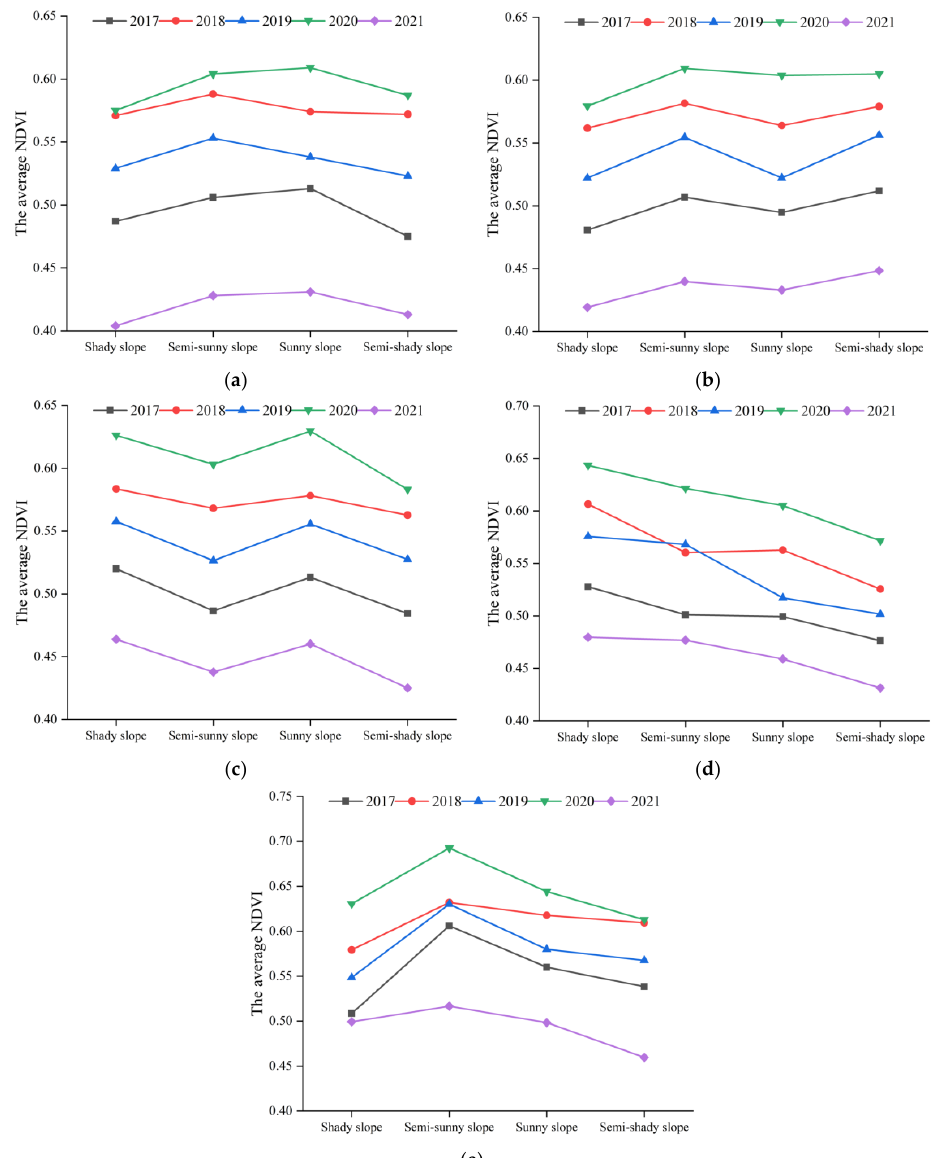
Figure 20. NDVI of different slopes and aspects: ( a ) gentle slope — different aspects; ( b ) incline slope — different aspects; ( c ) slanted slope — different aspects; ( d ) steep slope — different aspects; ( e ) rapidly steep slope — different aspects.